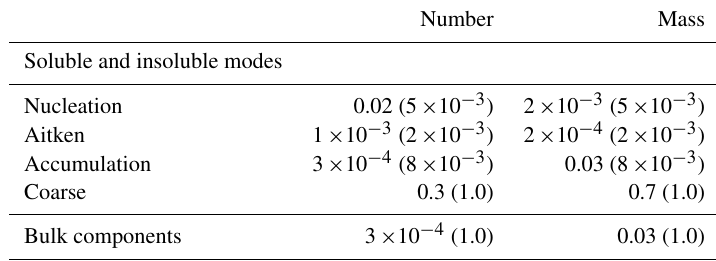
Table 3. Number and mass scavenging coefficients (mm − 1 ) for stratiform below-cloud scavenging. The numbers in parentheses indicate the values used in the TM5 and EC-Earth versions documented in van Noije et al.